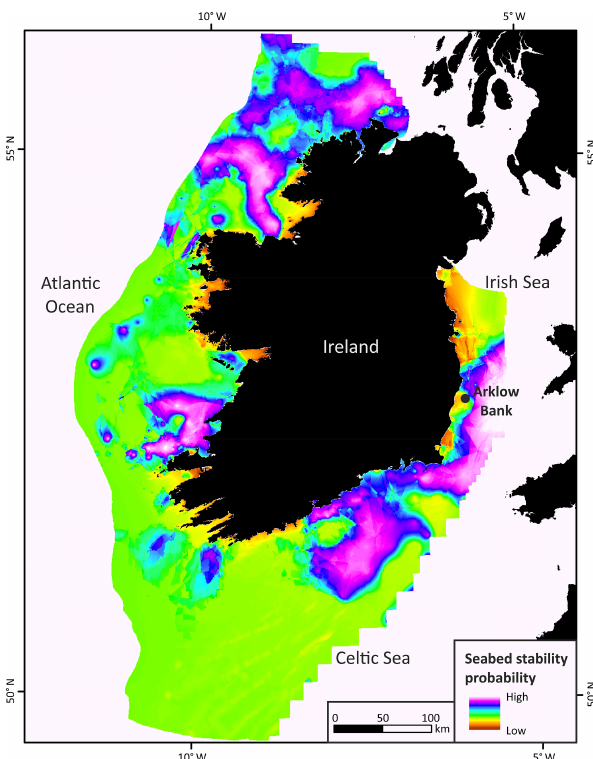
Figure 5. Raster output from the final seabed sediment stabil- ity model combining coded sediment properties, bathymetry, and slope. The location of Ireland’s only offshore wind farm, Arklow Bank, is shown as a labelled black